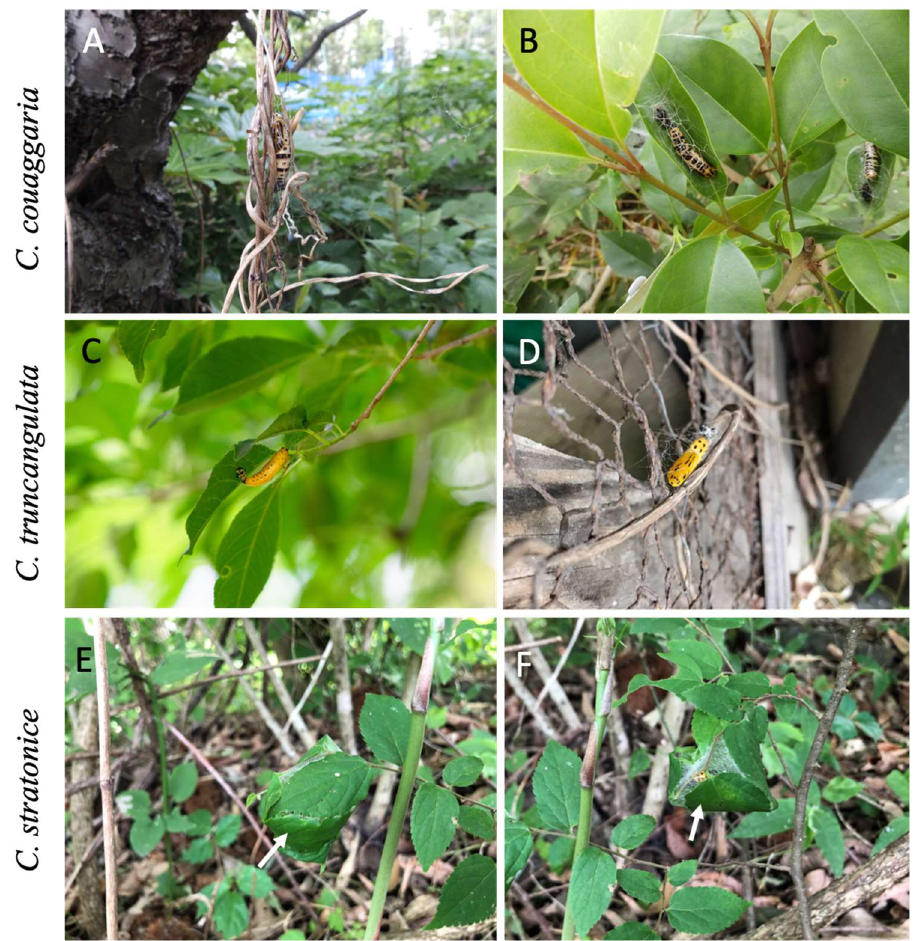
Figure 2. Pupation sites in the field of the three species of Cystidia moths; C. couaggaria ( A , B ), C. truncangulata ( C , D ), and C. stratonice ( E , F ). They pupate on the surface of twigs ( A , C ), upside a leaf ( B ), underside a leaf ( C ), and within the leaves stitched with silk, showing by white arrows ( E , F ).